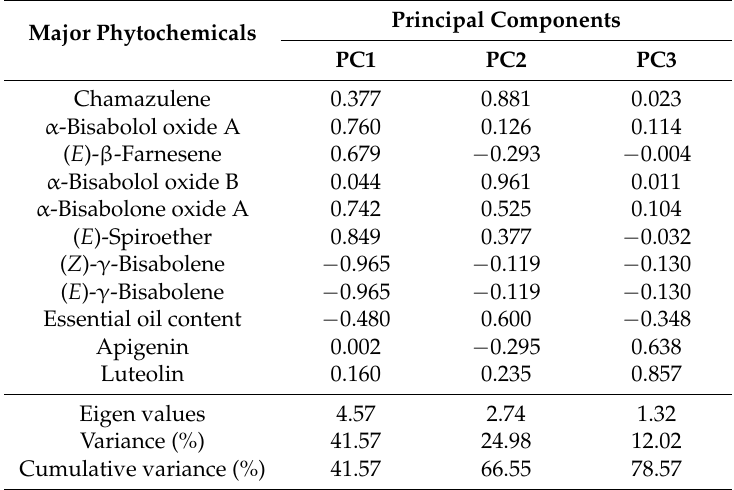
Table 2. Eigenvalues, variance and cumulative variance for three principal